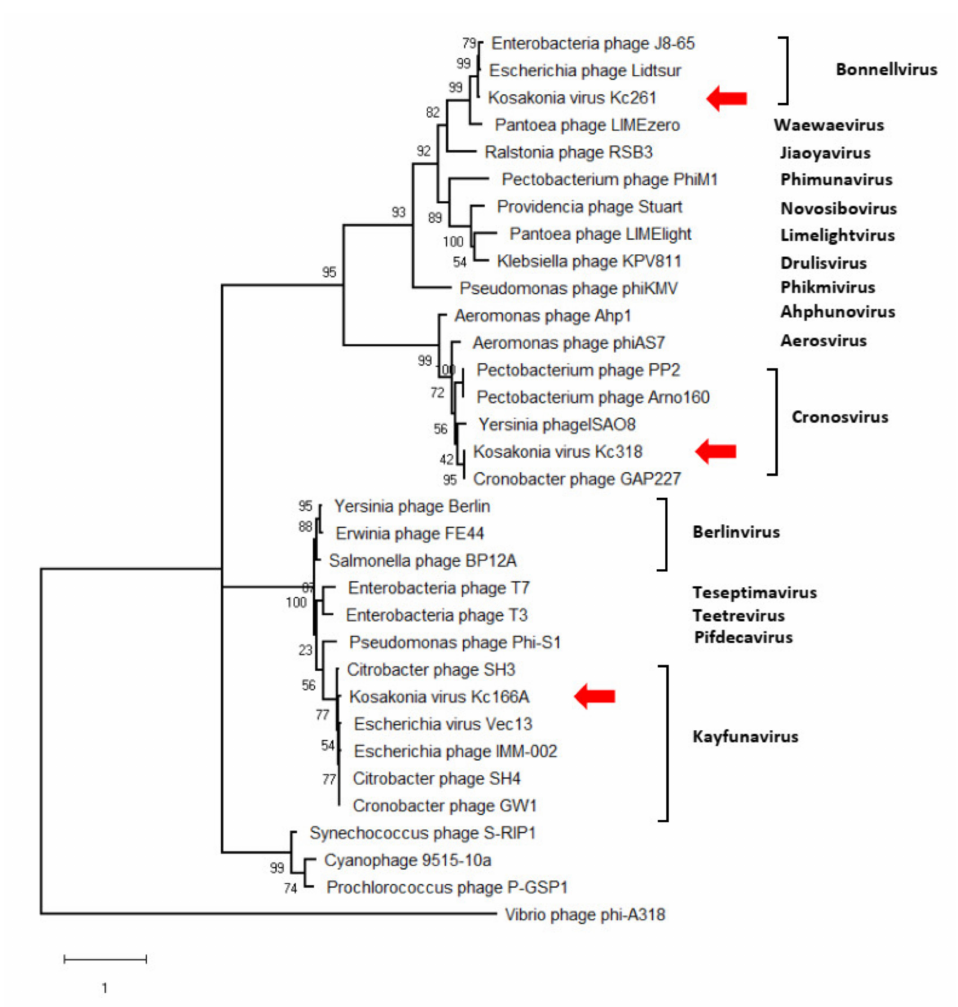
Figure 4. Maximum-likelihood phylogenetic tree computed on mCP amino acid sequences. Bootstrap values after 1000 repetitions are shown on the